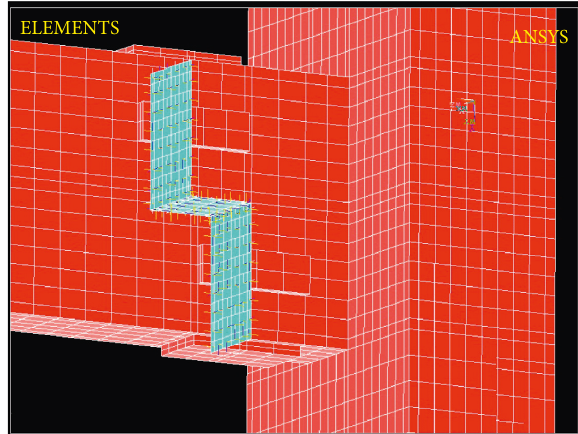
Figure 8: Contact elements in beam-column joint. Table 1: Statistical table of the accuracy of system model